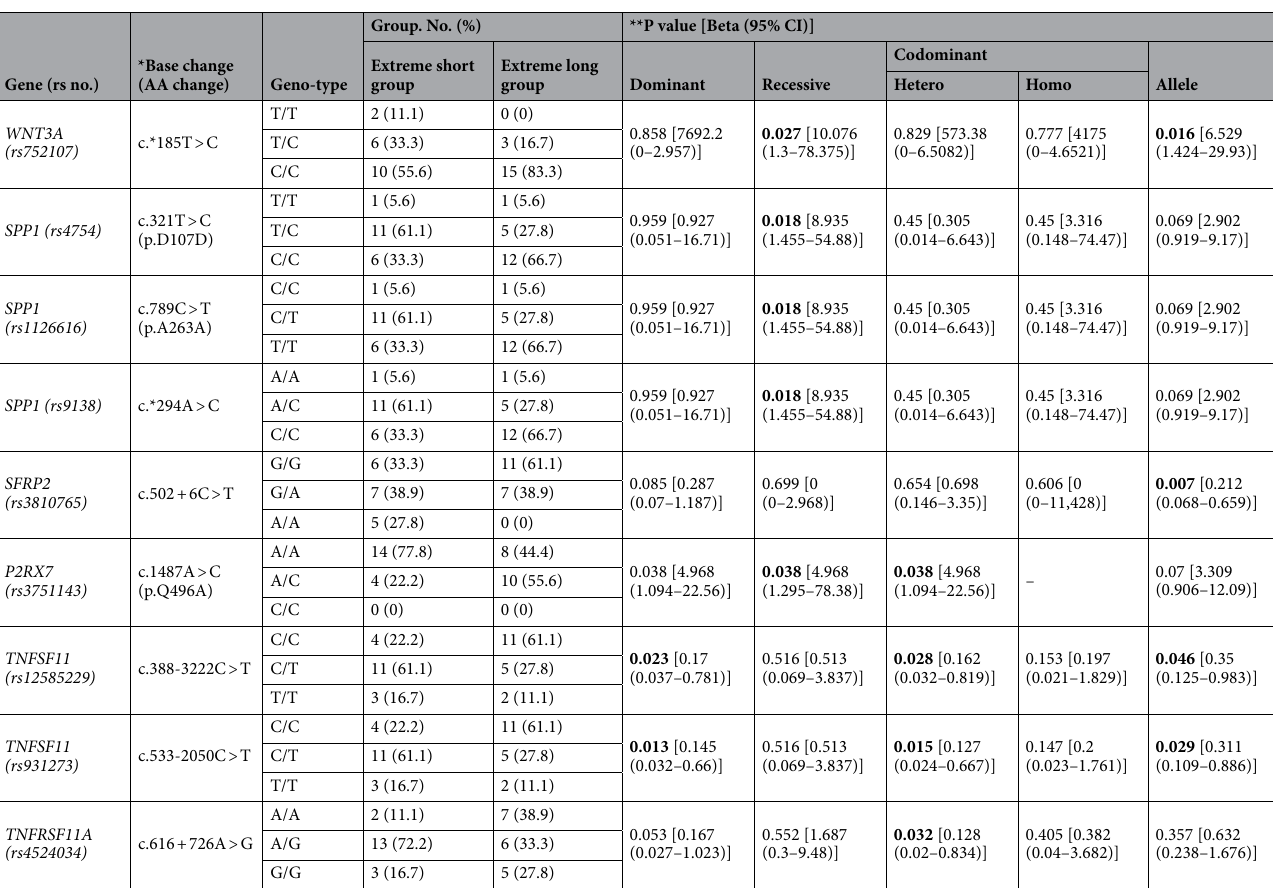
Table 3. SNPs significantly associated with orthodontic treatment duration (leveling and retraction period) in targeted sequencing study. CI Confidence interval, Beta Beta coefficient. P value was adjusted for gender and age at the beginning of treatment. Bold values denote statistical significance at the P < 0.05 level. *Nucleotide location number was assigned according to the WNT3A (Transcript ID: NM_033131.3), SPP1 (Transcript